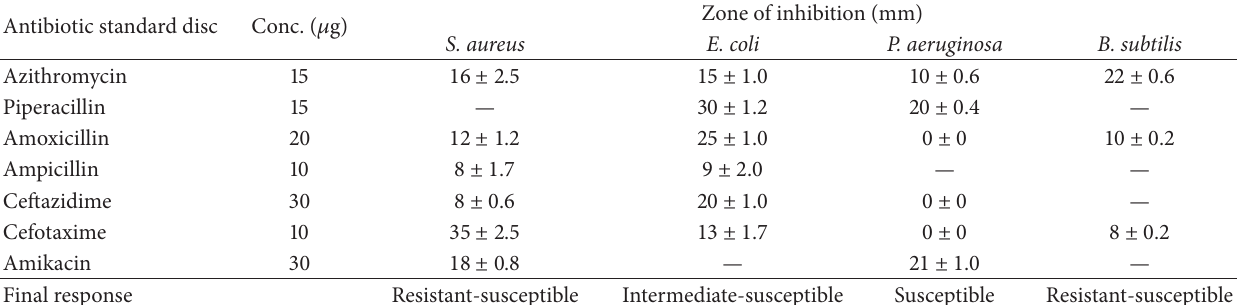
Table 1: Zone of inhibition (mm) produced by the bacterial strains against standard antibiotic discs.